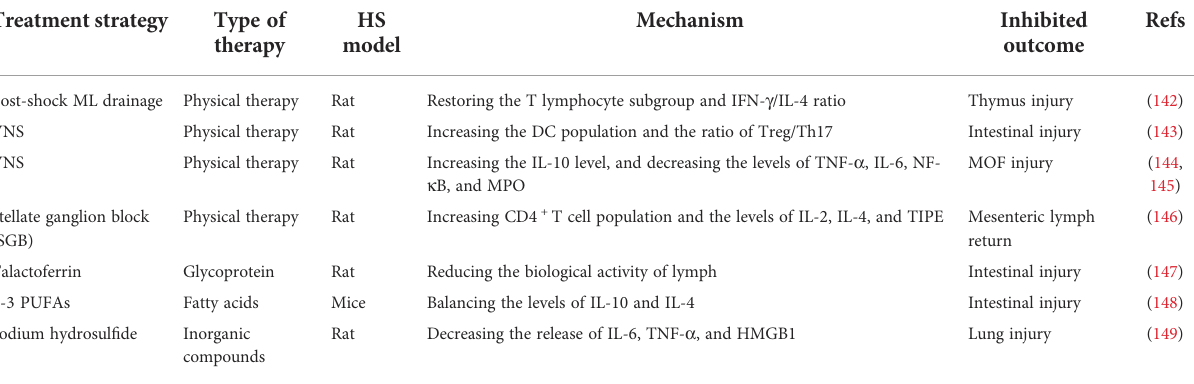
TABLE 5 Summary of the applications of physical therapy, glycoprotein, fatty acids, and inorganic compounds in the hemorrhagic shock model. Treatment